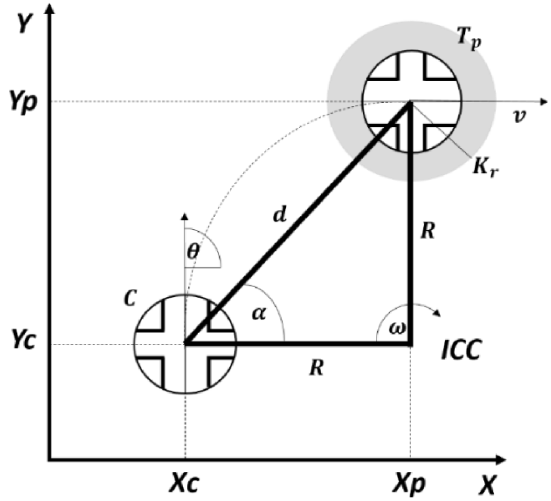
Figure 7. Position control